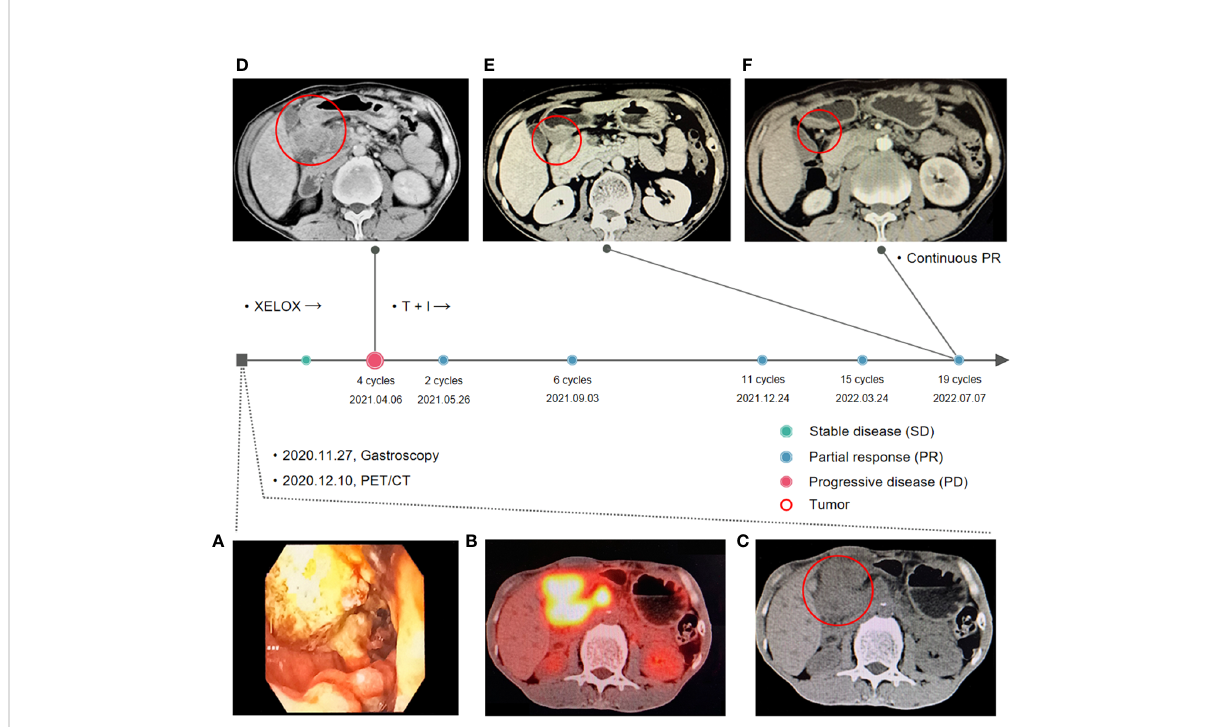
FIGURE 1 Treatment timeline. (A) Gastroscopy report at fi rst visit: A large annular mass was observed in the duodenal bulb, extending to the upper part of the descending part. (B, C) Positron emission tomography/computed tomography (PET/CT) before the fi rst-line treatment: a signi fi cant uneven thickening of the intestinal wall of duodenal bulb (47 × 40 mm) and multiple lymph node metastases. (D) Computed tomography after four sessions of XELOX treatment. The tumor progressed and fused with surrounding lymph nodes after four cycles of XELOX (65 × 63 mm). (E, F) Computed tomography after two and 19 sessions of tislelizumab in combination with